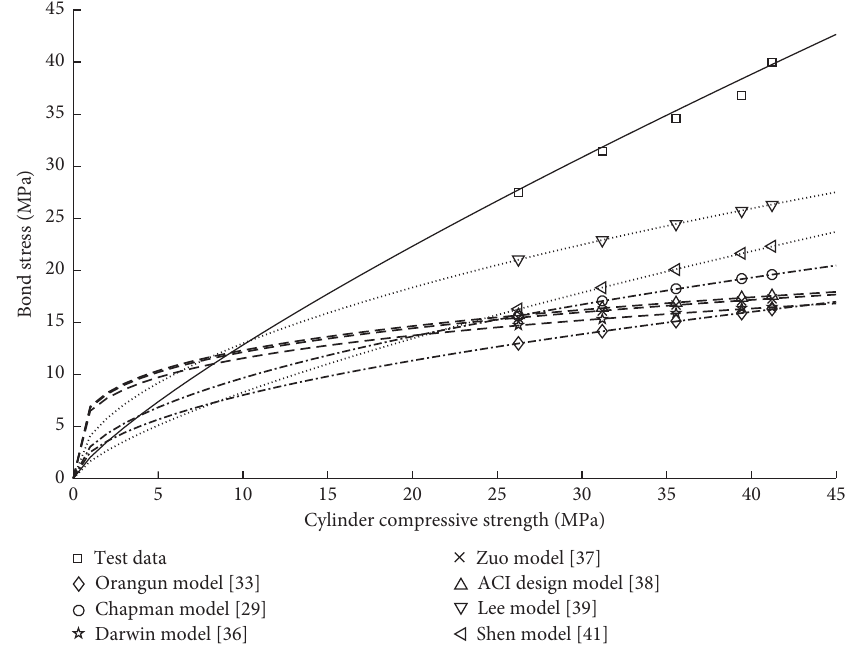
Figure 7: Relationship between bond strength and cylinder compressive strength of different models. Table 7: Theoretical and experimental results of bond strength of SAP